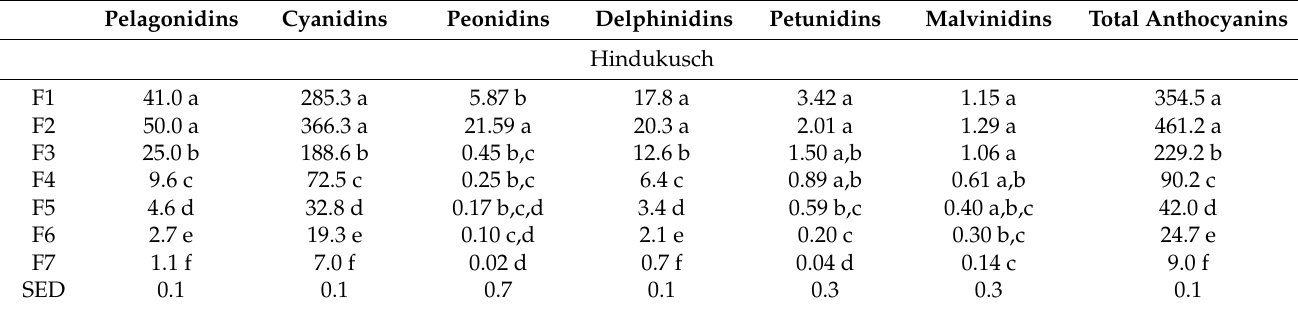
Table 6. Anthocyanins contents ( µ g/g) in barley pearling fractions.